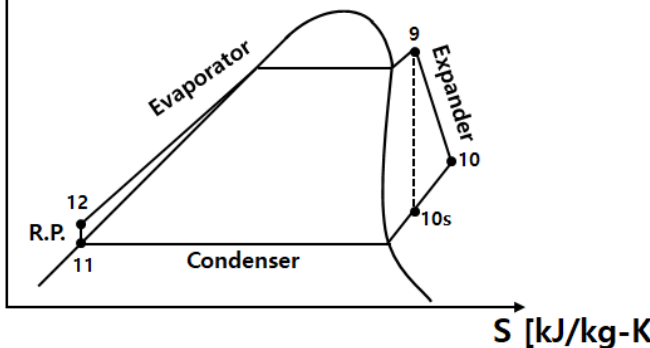
Figure 3. Thermodynamic T-s diagram for ideal Organic Rankine Cycle (ORC) cycle (R.P. is the meaning of refrigerant pump).